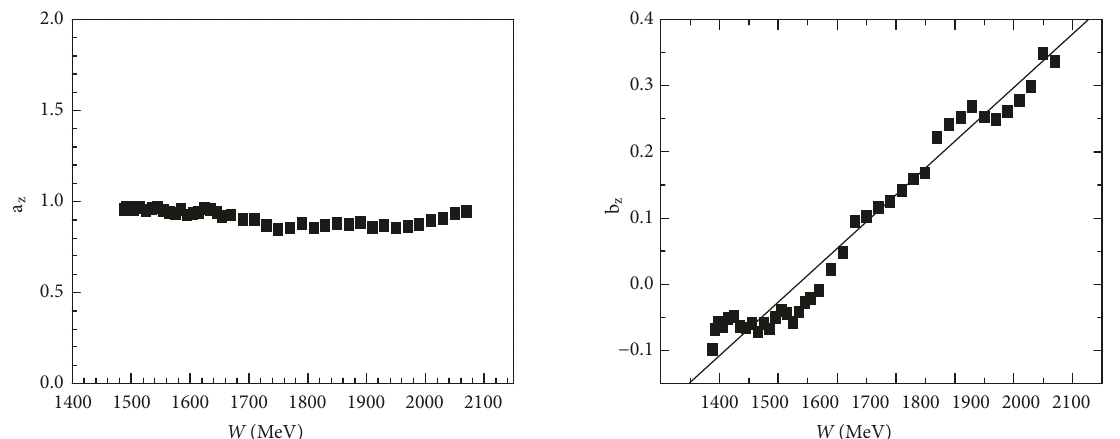
Figure 9: The 𝑎 𝑍 and 𝑏 𝑍 values taken for different bins of final state energy 𝑊 . The symbols are the values taken in Figures 4–6. The straight line is a fitted